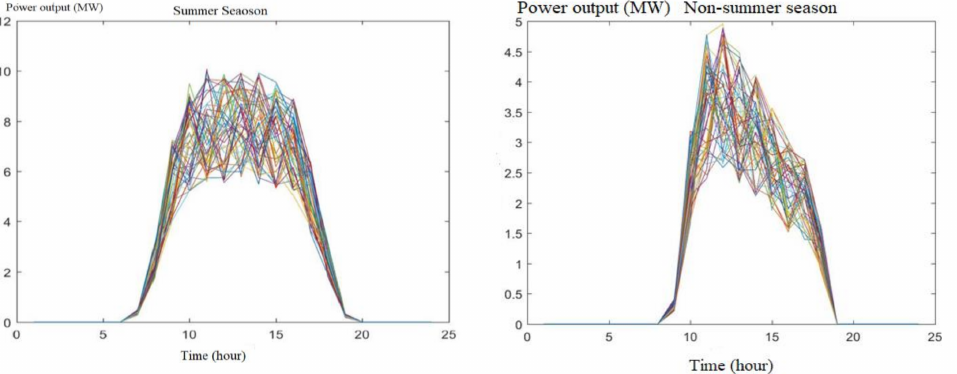
Figure 7. The power output of PV in the summer and non-summer seasons.